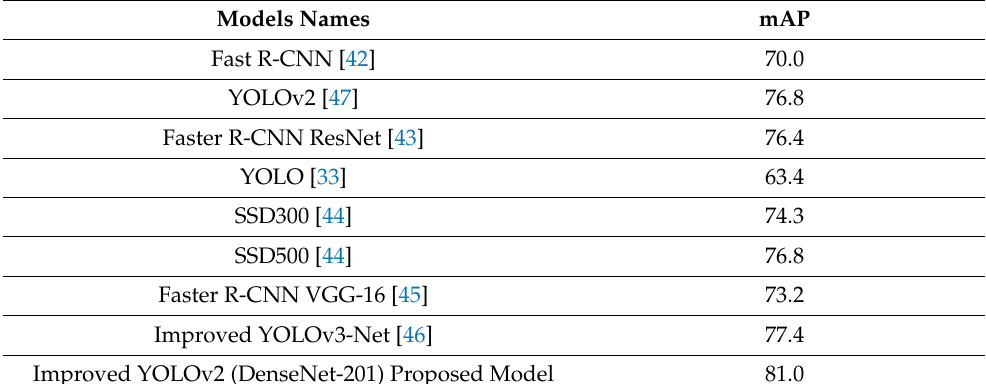
Table 5. Comparison of different Network Models using PASCAL VOC 2007.